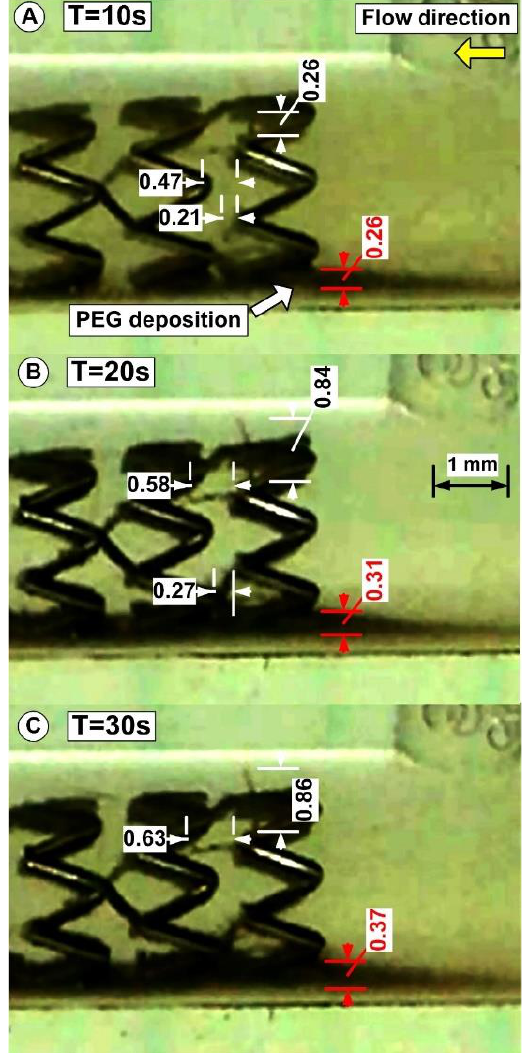
Figure 11. Detail regarding the chain-like particle structure evolution during injection time of 30 s. Data shows chain structure development and growth for chains Ch 1, Ch 2, and Ch 3 (according to Figure 9). Additionally, the figure presents the PEG_MNC deposition evolution during the injection period of 30 s (red arrows). All presented data are in mm.